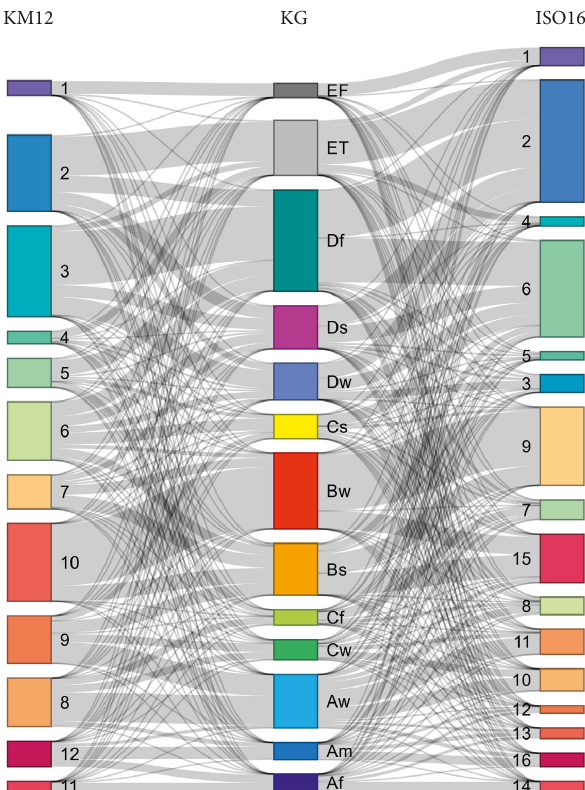
Figure 10: Proportions of coverage of climate regions across k - means 12 clusters, K¨oppen–Geiger level 2, and ISODATA 16- cluster classification